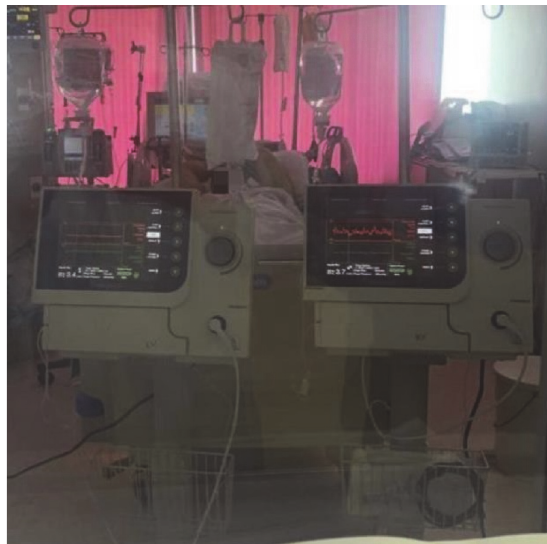
Figure 2: In situ Bi-Pella: consoles for the right and left ventricle.